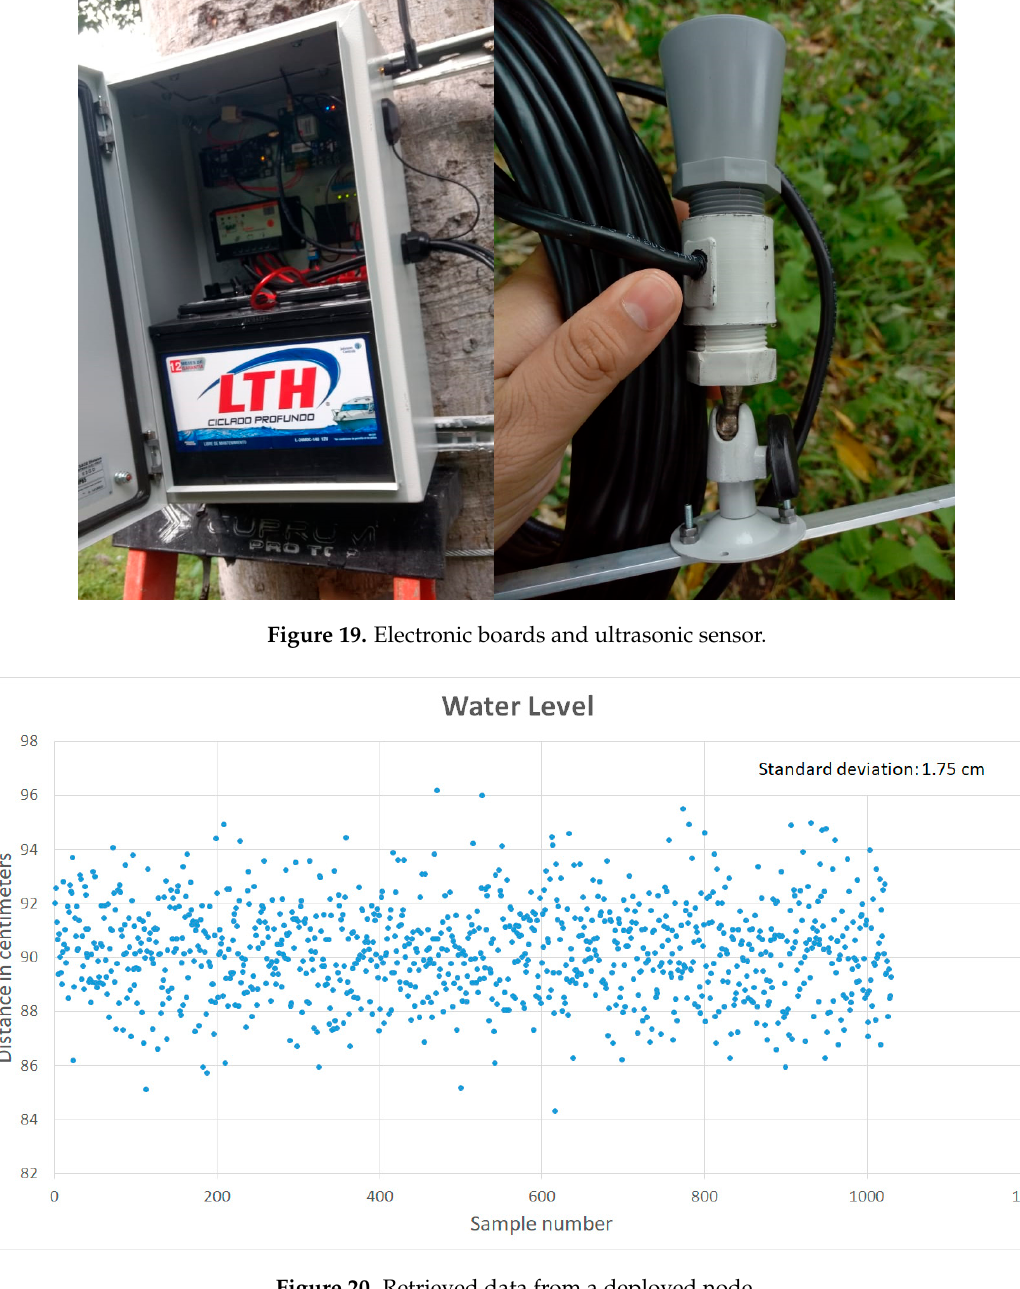
Figure 20. Retrieved data from a deployed node.